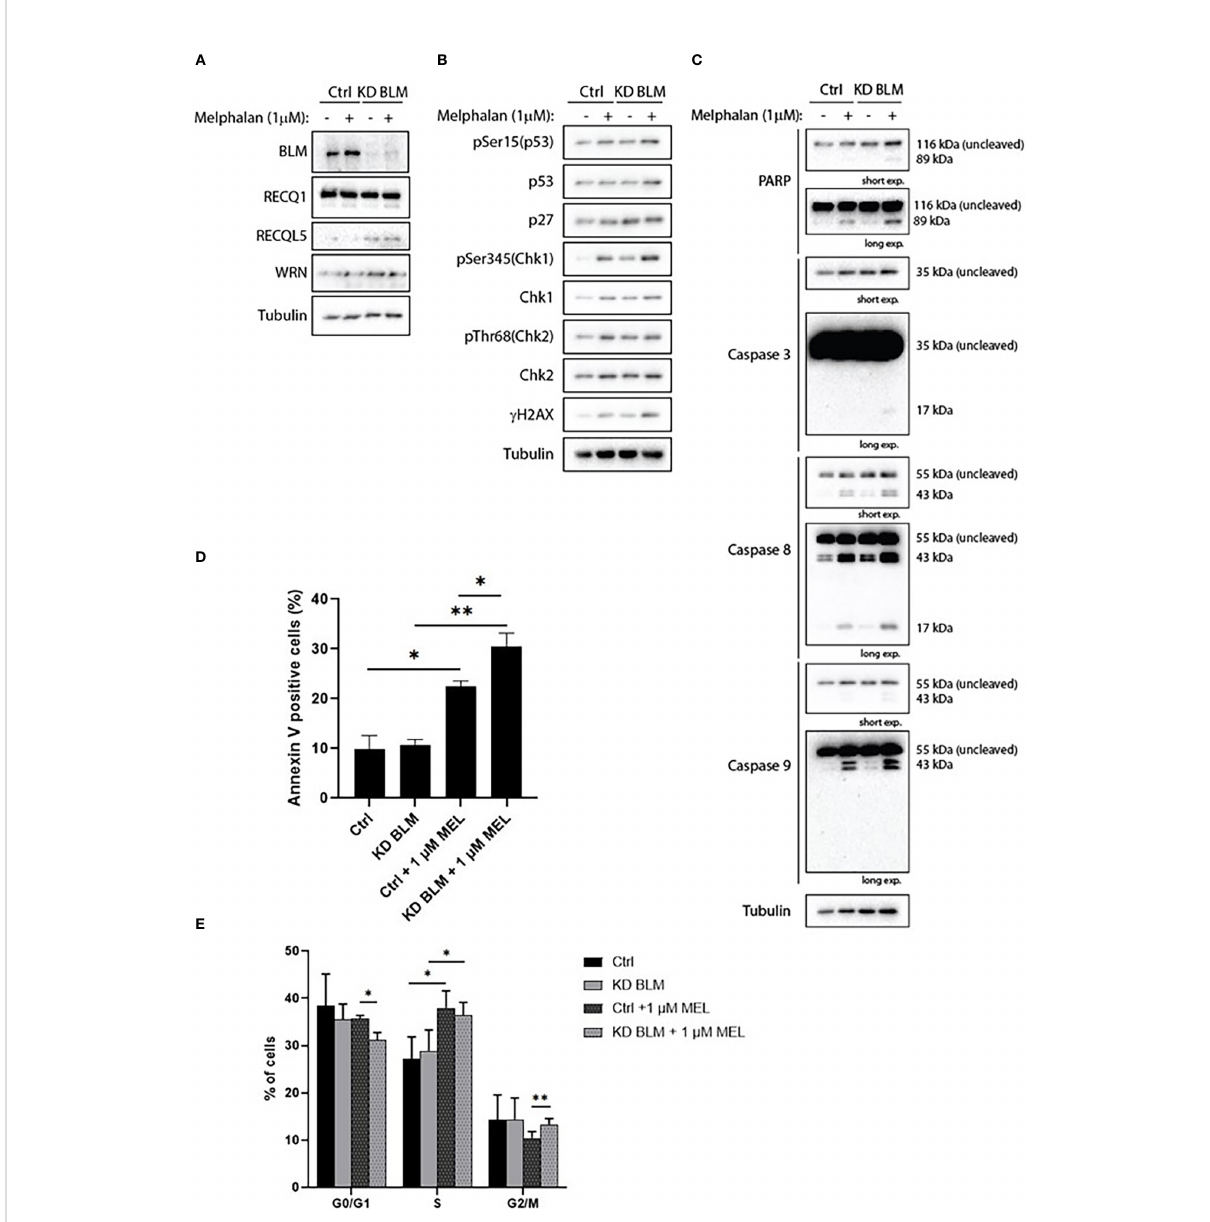
FIGURE 8 BLM depletion sensitizes MM cells to melphalan. XG2 cells were transduced with control lentiviruses (Ctrl) or miRNA against BLM to stably knock-down its expression (KD BLM). Both cell lines were treated with 1 m M melphalan for 96 hours and samples were collected to analyze (A) BLM depletion and protein levels of the other RECQ helicases; (B) cell cycle and DDR markers by western blot; (C) PARP and caspases cleavage as apoptosis markers by western blot; (D) apoptotic cells (Annexin V+) by fl ow cytometry; (E) cell cycle distribution using